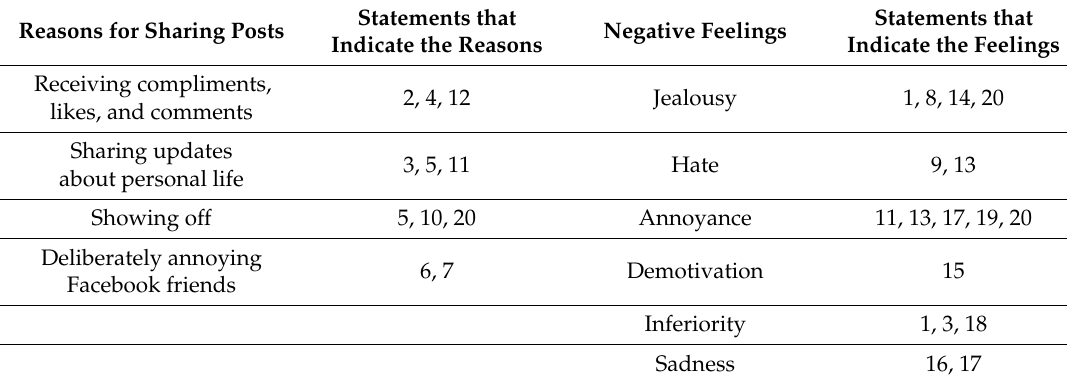
Table 4. Reasons for sharing posts and the negative feelings they